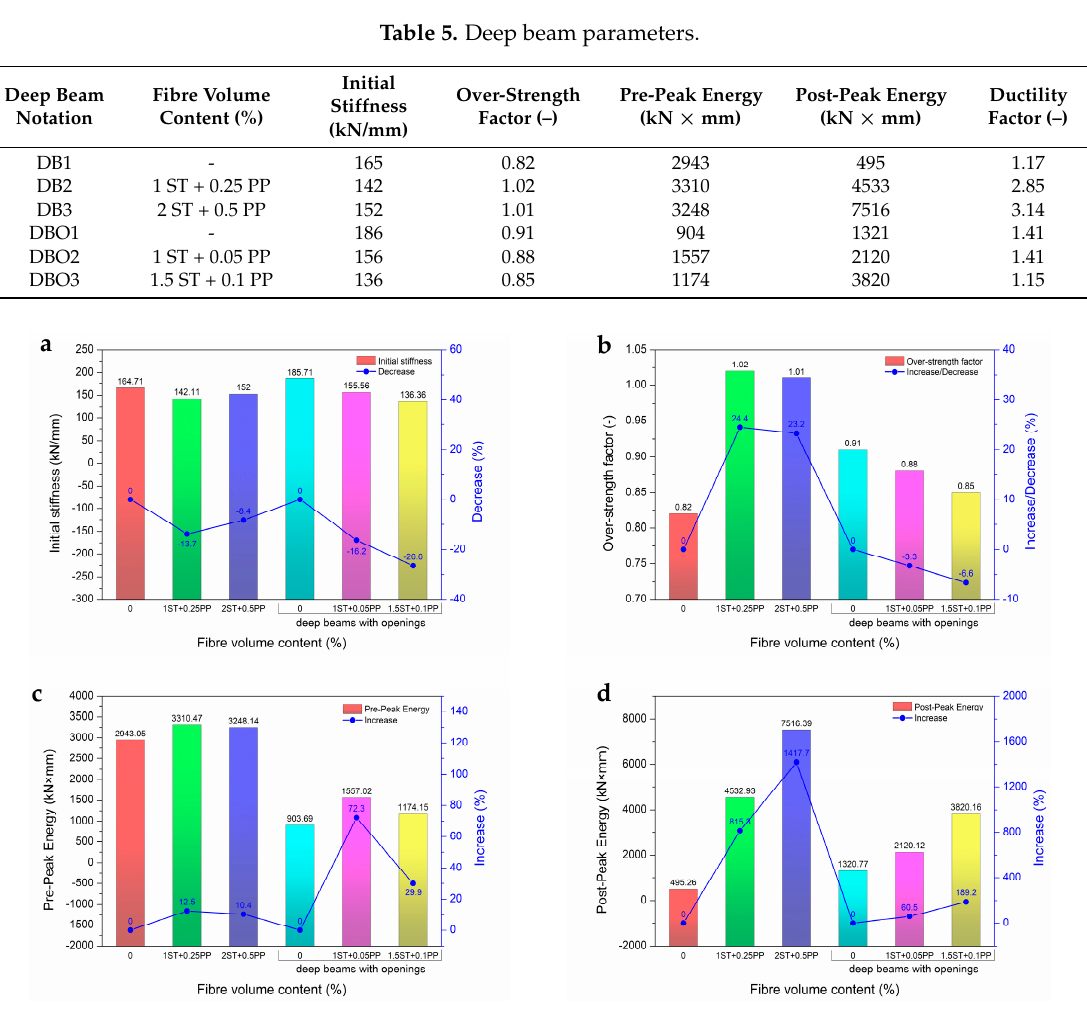
Table 5. Deep beam parameters.